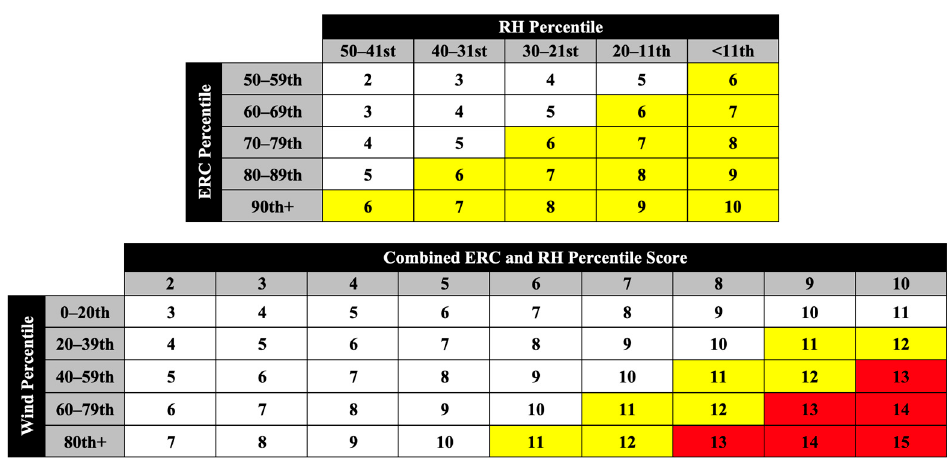
Figure 7. Categorical scores for percentiles of ERC, RH, and wind speed as a two-step decision matrix. Yellow boxes correspond to scores that suggest a warning may be necessary; red boxes indicate more severe conditions.